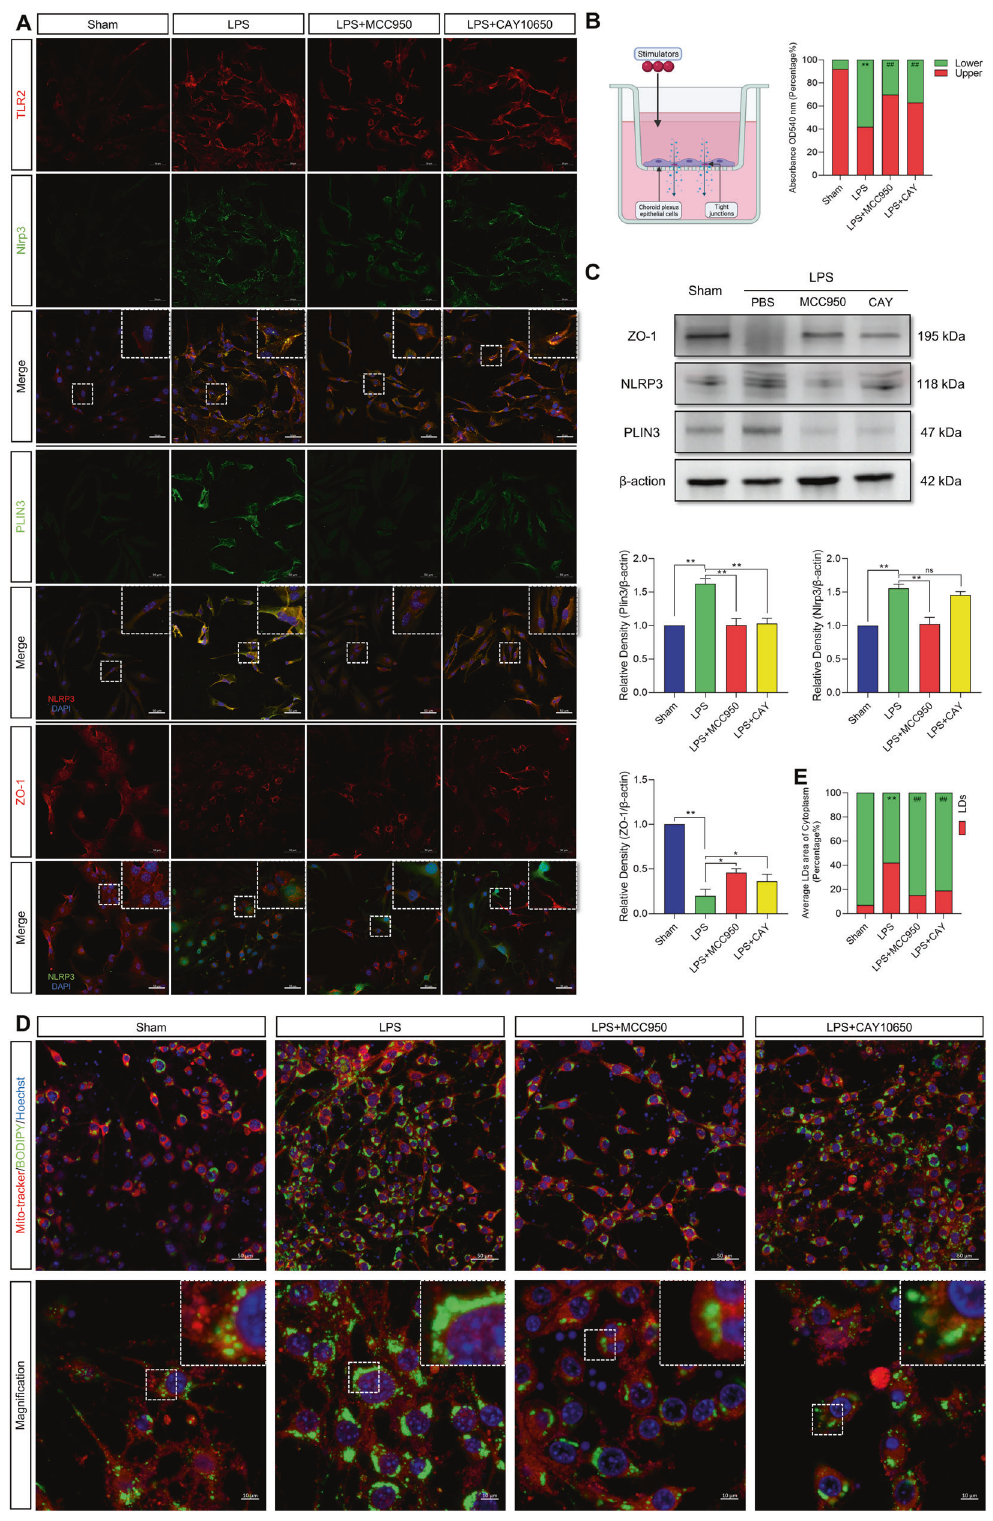
Fig. 7 LPS induces NLRP3 activation in CPECs and disrupts tight junctions by regulating LD formation. A Immuno fl uorescence multiple- localization staining results of TLR2, NLRP3, PLIN3 and ZO-1 in CPECs under LPS stimulation and MCC950 or CAY10650 treatment. Scale bar = 50 μ m. B Barrier function assessment in a CPEC-composed B-CSFB as measured by dextran leakage ( n = 3, one-way ANOVA). C The expression of ZO-1, NLRP3 and PLIN3 in LPS-induced CPECs and MCC950 or CAY10650 treatment ( n = 3, one-way ANOVA). D Images of LDs stained with BODIPY and mitochondria labeled with MitoTracker. Scale bar = 50 μ m (upper), Scale bar = 10 μ m (lower). E Results of LD coverage area of cells ( n = 3, one-way ANOVA). The results are expressed as the mean ± SD, ** P < 0.01, * P < 0.05, ns P >